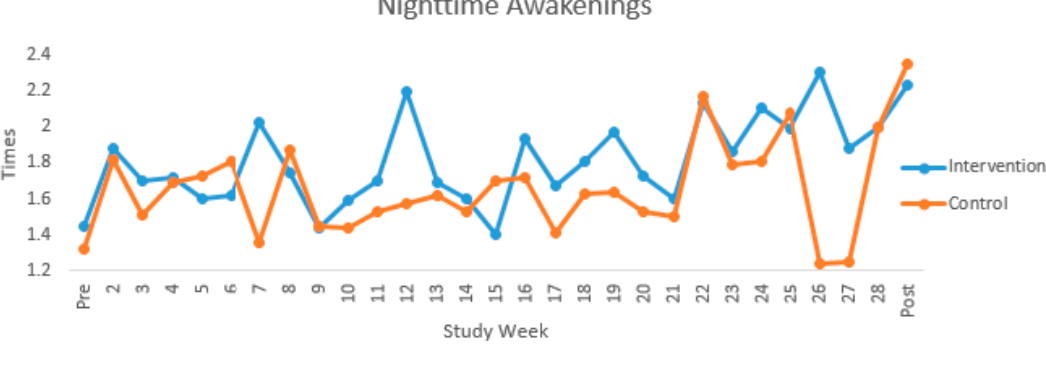
Figure 3. Nighttime awakenings trajectory.